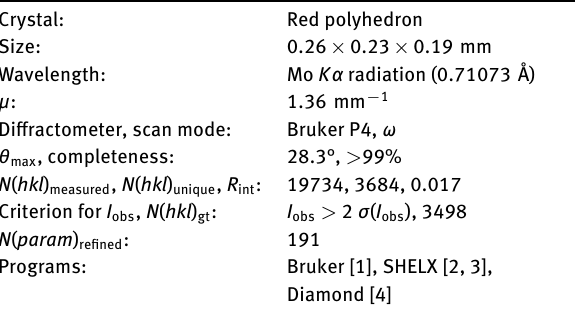
Table 1: Data collection and